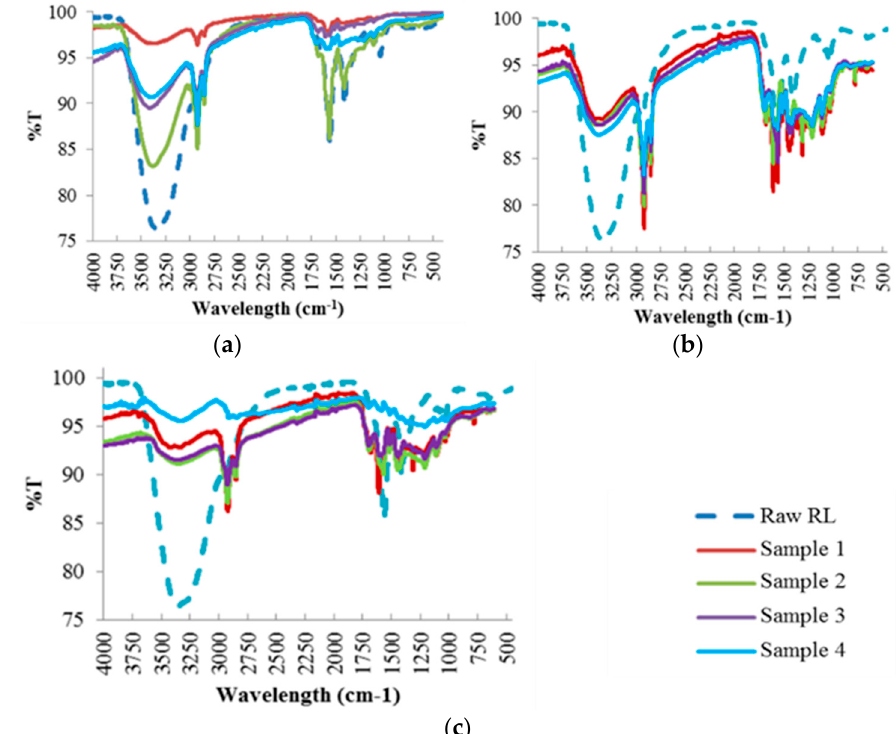
Figure 3. FTIR Spectra of the Hydrochar Samples at Different Reaction Temperatures: ( a ) 190 °C; ( b ) 220 °C; ( c ) 250 °C.